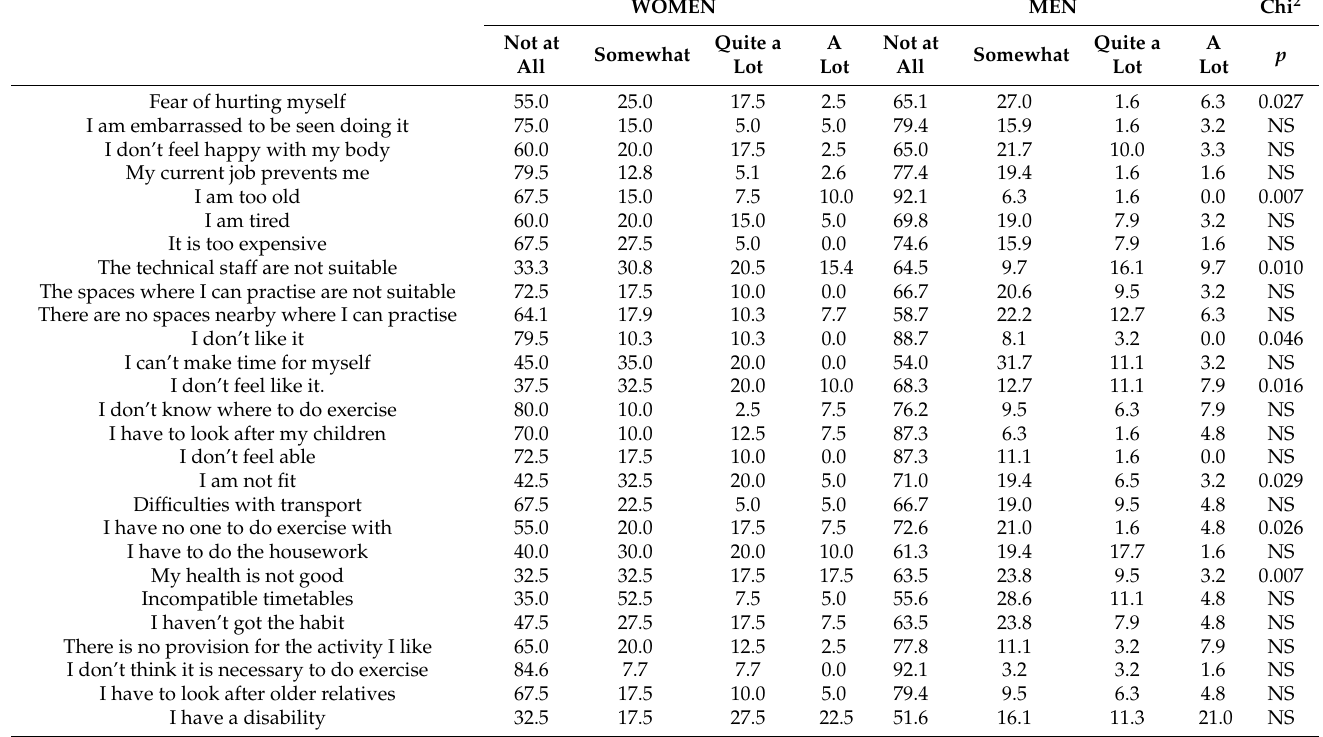
Table 3. Results (%) referring to the differences in the perceived barriers to practising physical activity and sport according to